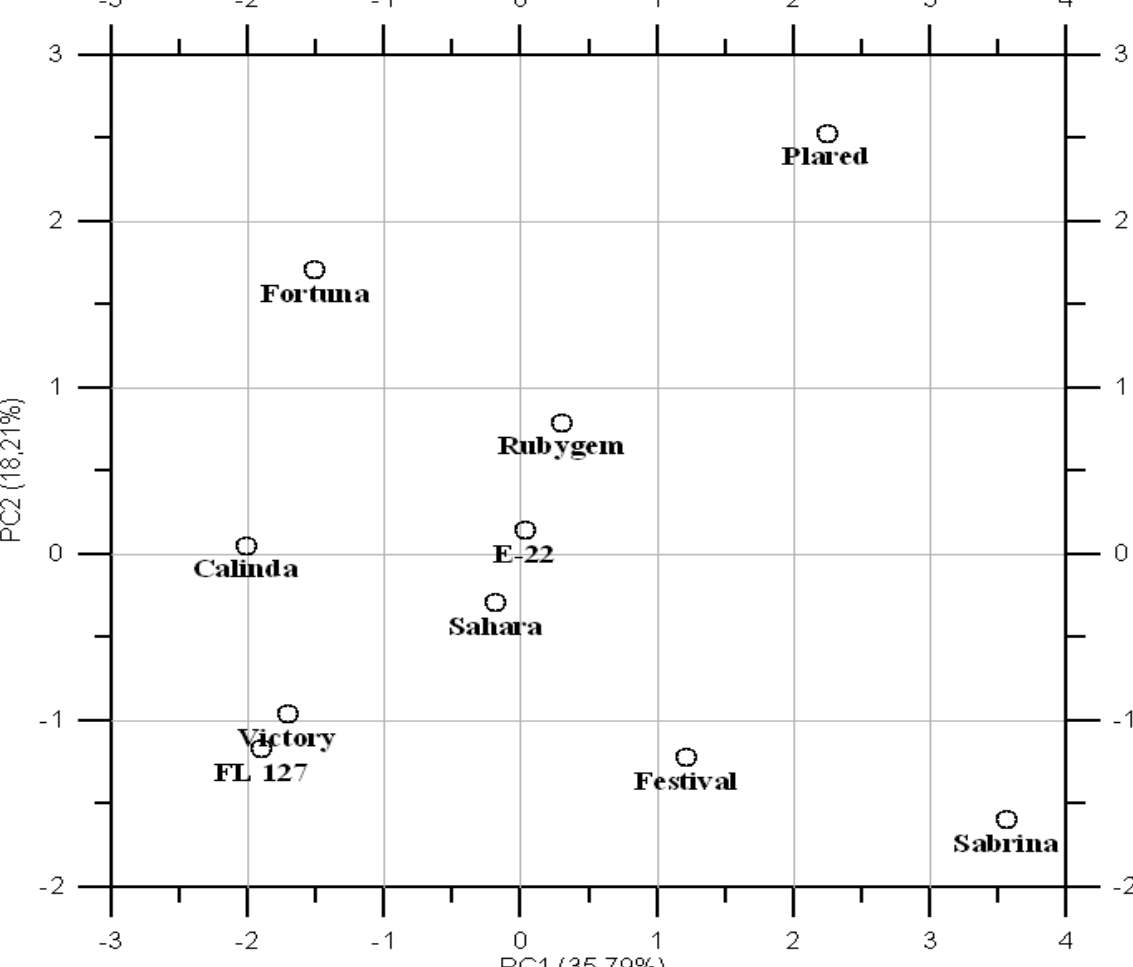
Figure 1. Principal component analysis (PCA) for different varieties and phenolic profile (individual phenolic compounds, total phenols content, and DPPH).